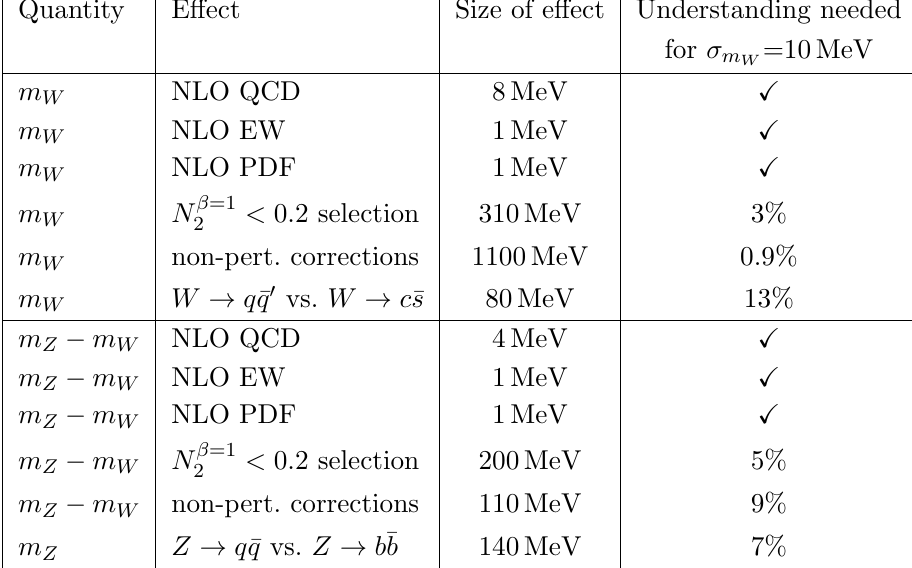
table 5. Similarly, the N (cid:12) =1 dependence plot shows the largest shifts when adding non- 2 perturbative e(cid:11)ects. However, a similar trend is observed between W and Z bosons. For a very loose selection on N (cid:12) =1 a small deviation in perturbative e(cid:11)ects is also observed. 2